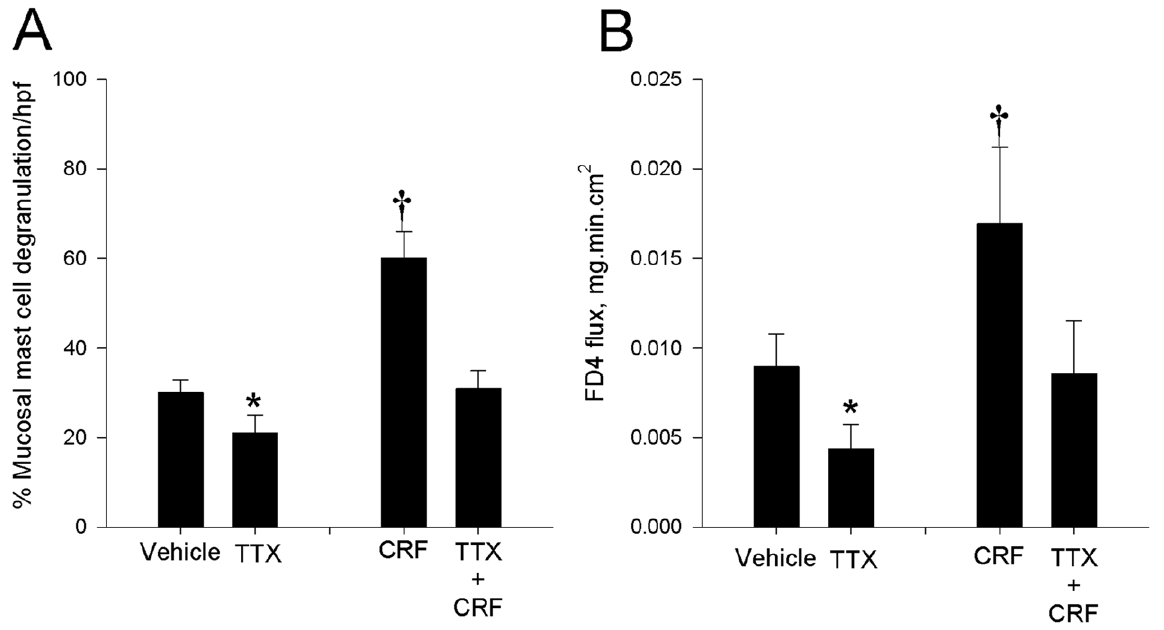
Figure 8. The Role of the enteric nervous system in CRF-mediated mast cell activation and FD4 flux. Toluidine blue staining of histological sections (100 X magnification) (A) and quantitation of the % of degranulated tissue mast cells (B) in porcine ileum revealed increased degranulation of mast cells in CRF–treated tissues. Treatment of ileal tissues with tetrodotoxin (TTX) inhibited mast cell degranulation and FD4 flux (C) under basal and CRF-stimulated conditions and inhibited. For histological analysis, values represent means 6 SE; n= 6 animals and are presented as the percentage of total cell count per treatment at 20 6 magnification. FD4 flux values represent means 6 SE; n= 6 2 8 animals Symbols (*, { ) differs significantly by p , 0.05 from vehicle